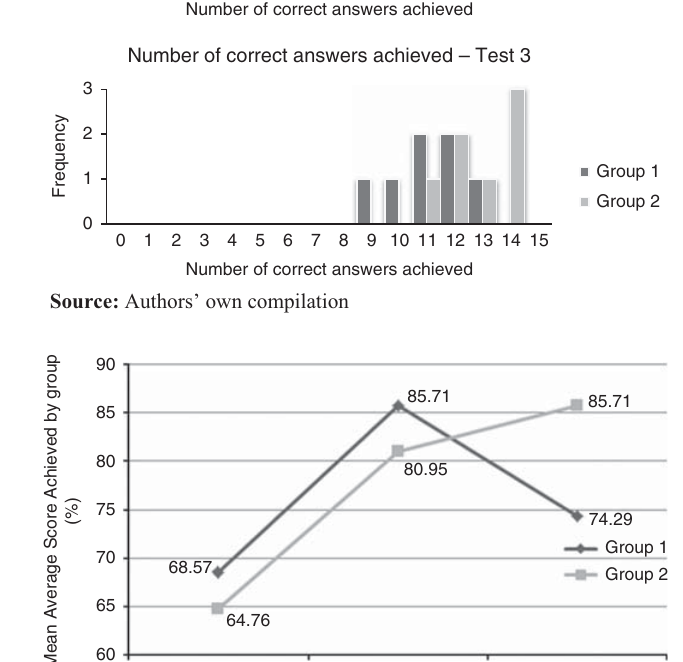
Figure 7. Cumulative percentage of the mean average group